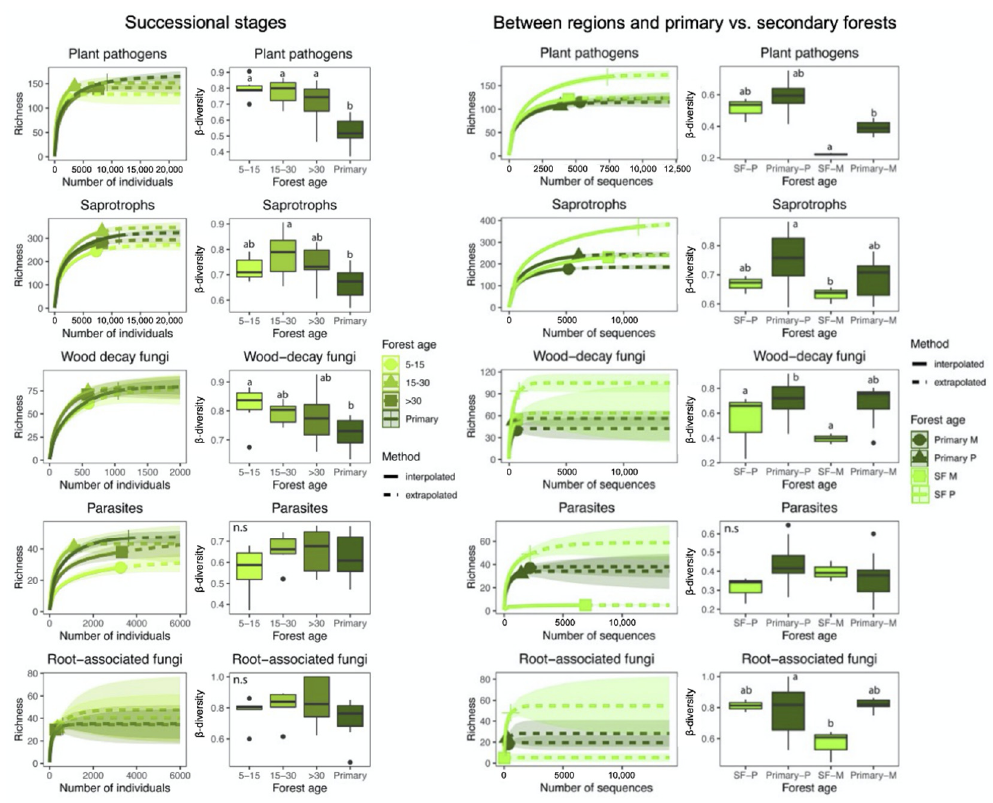
Figure 2. Hill’s N0 interpolated and extrapolated richness values of fungal functional groups across different stand age classes in both regions combined and in primary and all secondary forests (SF) between geographic regions two regions, Piro (P) and Mogos (M). Unbroken and dashed parts of the curve denote interpolated and extrapolated values, respectively, and the shaded zone around each curve denotes the 95% confidence intervals. Boxplots show compositional turnover ( β -diversity) of the various functional groups among samples within forest types, calculated as abundance-based Jaccard similarity index. Means were compared using ANOVA and Tukey’s HSD tests, with letters denoting significant differences within each